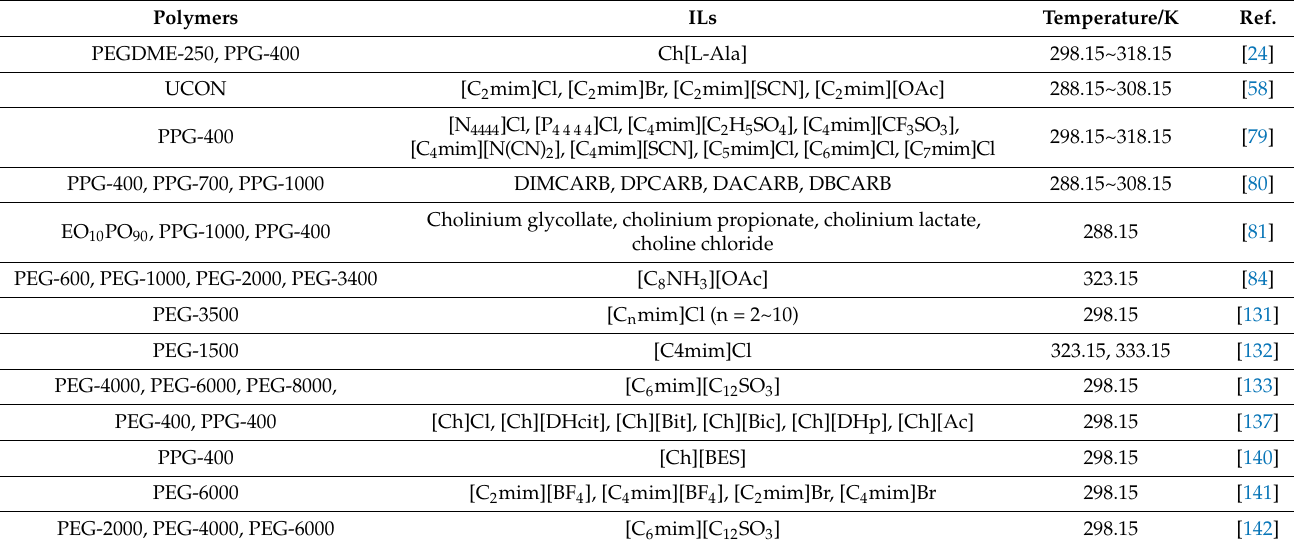
Table 2. Some polymers commonly used in the IL-based